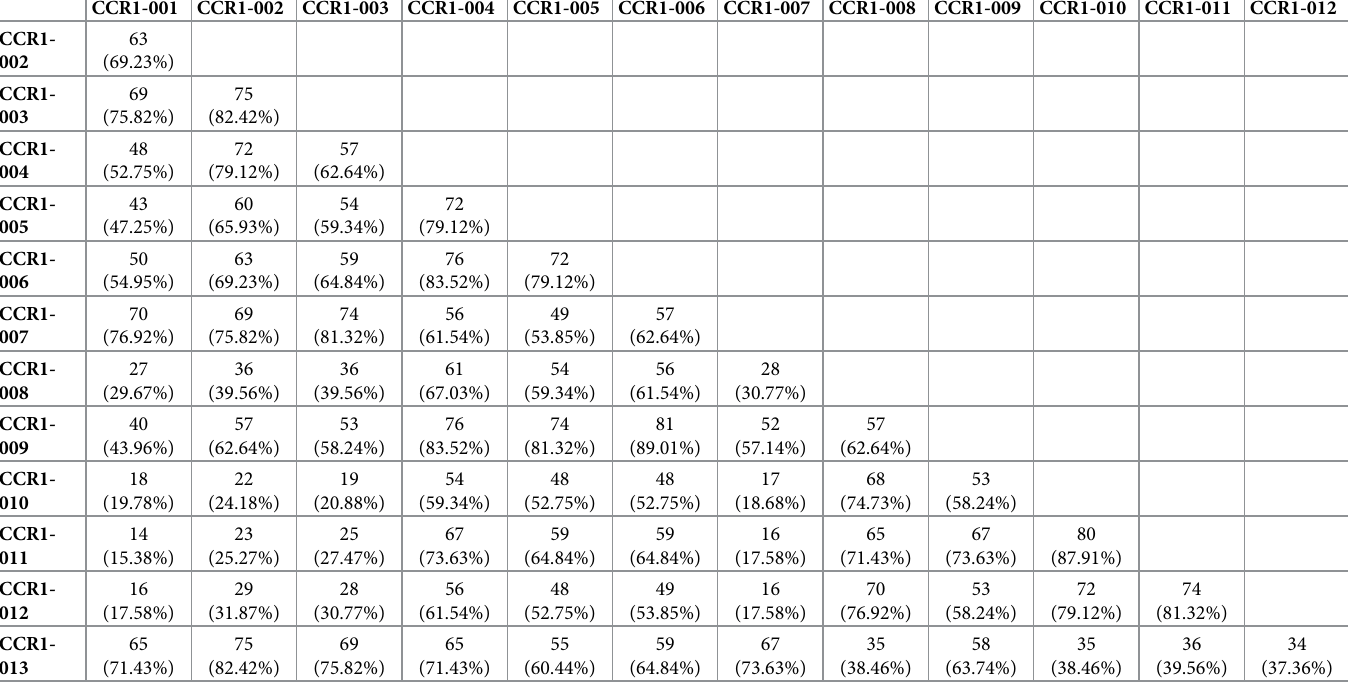
Table 4. The number (percentage) of concordant RFs after ComBat harmonization between pairwise combinations of scans with different acquisition and